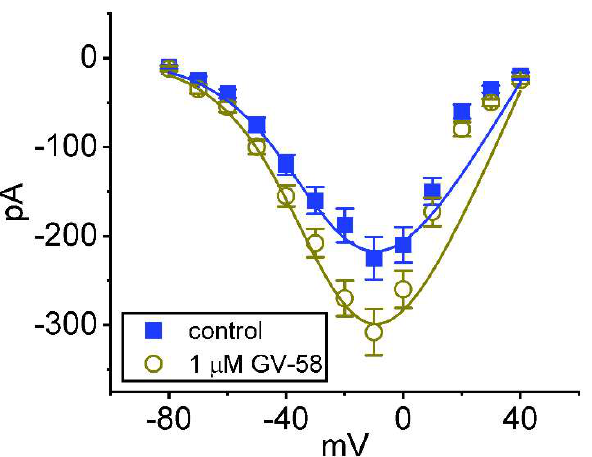
Figure 3. Effect of GV-58 on the steady − state I–V relationship of peak I Na . In these experiments, we voltage − clamped the cells at − 80 mV, and various depolarizing pulses from − 80 to +40 in 10 mV increments were applied to evoke I Na . Current amplitude at each depolarizing pulse was measured at the beginning of the voltage pulse. Data points shown in filled blue squares are control, and those in open brown circles were obtained in the presence of 1 µ M GV − 58. The smooth line taken with or without the GV − 58 addition was fitted with a Boltzmann function as detailed in Materials and